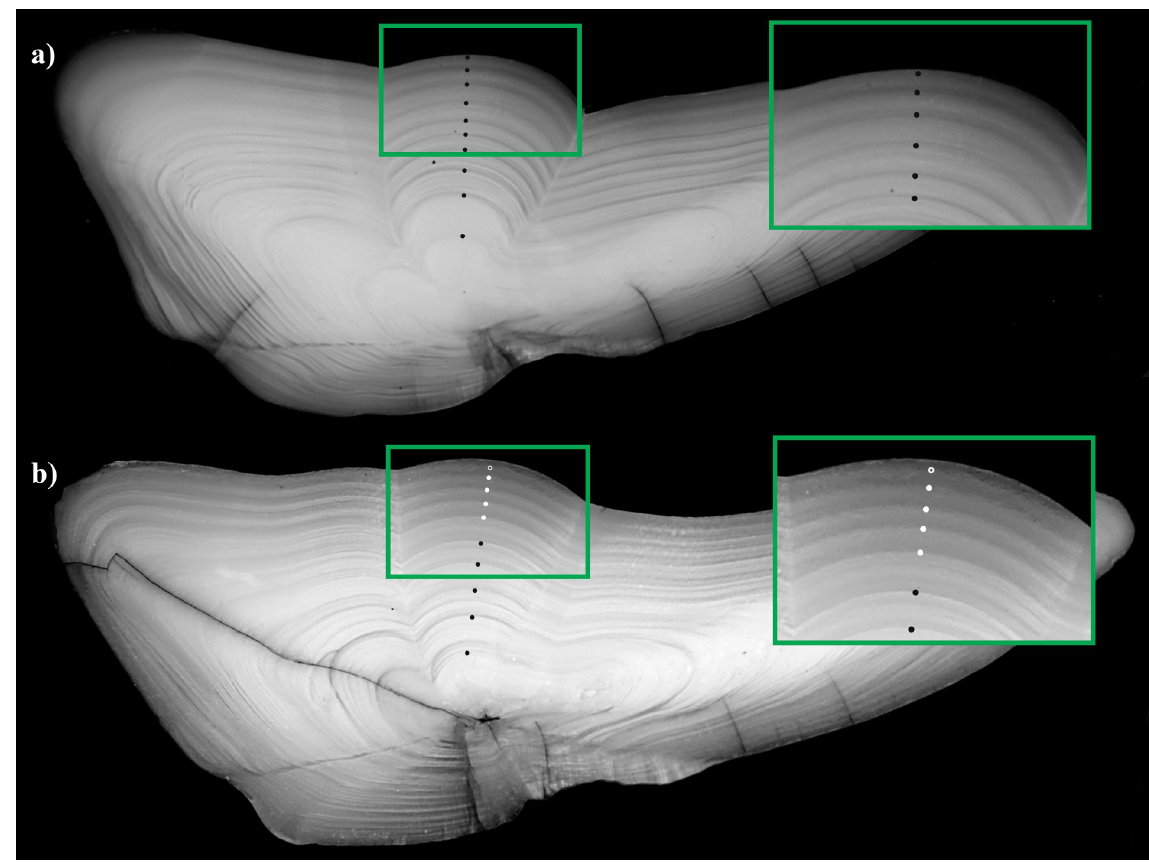
Fig 1. Comparison of spawning zone absence and presence in two NEA cod otoliths. a) 10-year-old fish with no visible spawning zones; b) 10-year-old fish with five visible spawning zones, identified as a cluster of similar-looking narrow increments with significantly wider translucent zones. Black circles mark regular growth increments; white circles mark spawning zones as described above; semi-filled white circles indicate an incomplete marginal increment that would likely be a spawning zone when fully formed.